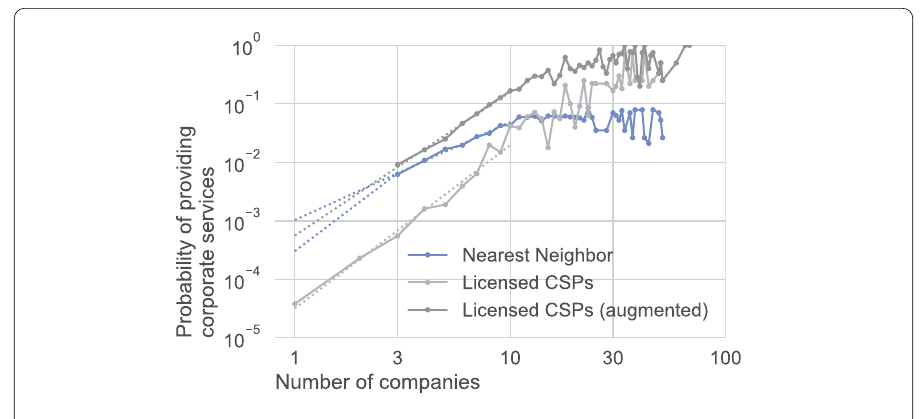
Figure 7 Extrapolation to smaller companies for the sample of licensed CSPs downloaded from the DNB (light gray), the full sample of licensed CSPs (dark gray), and the sample found with the nearest neighbor algorithm adjusted (blue). Note that the probability in the nearest neighbor sample has been adjusted using a uniform 11% true positive rate, as found in the manually annotated sample. Dashed lines show a fitted linear model for directors managing 1–10 companies. For the nearest neighbor sample, a second extrapolation using the slope of the full sample of licensed CSPs is